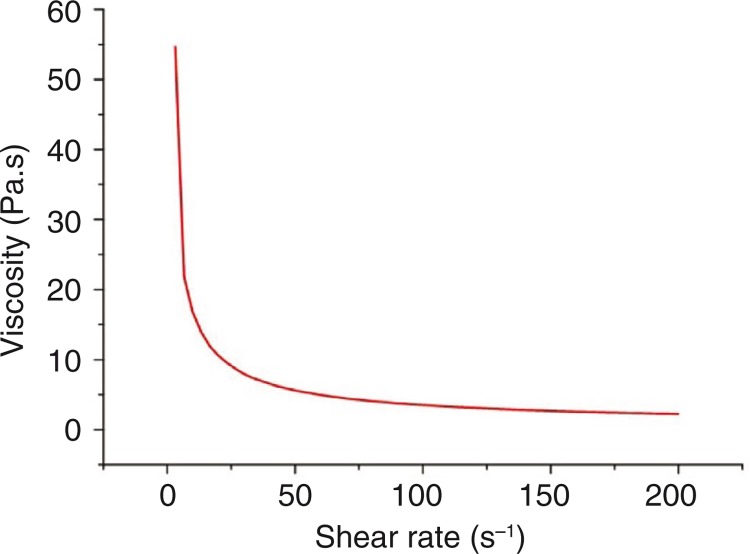
Viscosity analyses of beetroot gel at 25°C.